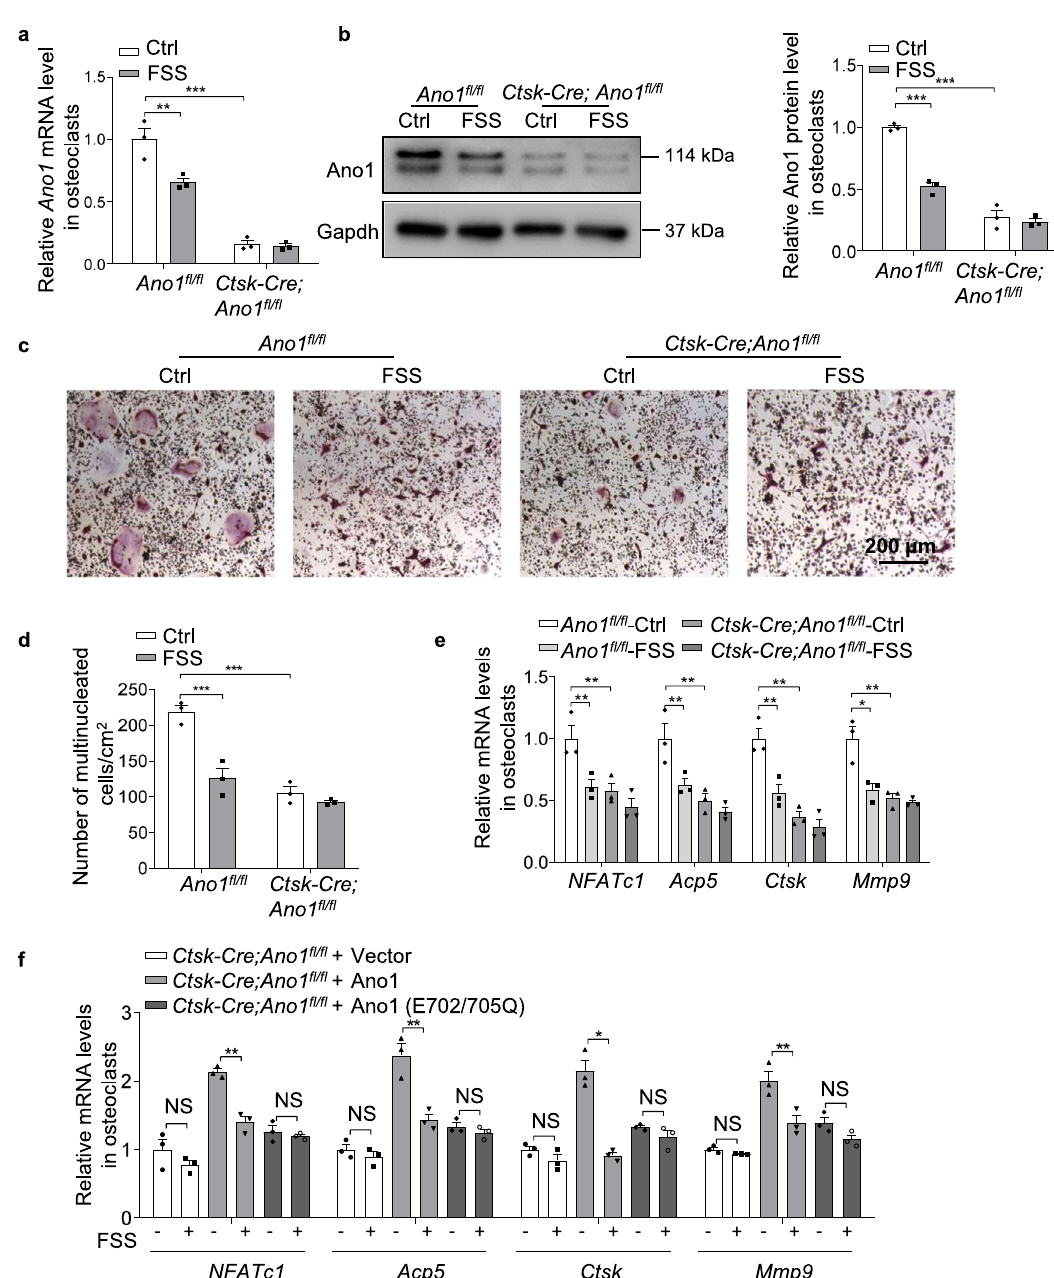
Fig. 2 Ano1 knock out blunts the inhibition of fl uid shear stress on osteoclast activity. a QRT-PCR analysis of Ano1 mRNA level in Ano1 fl / fl and Ctsk- Cre;Ano1 fl / fl osteoclasts after treatment with Ctrl or FSS (12 dyn/cm 2 , 30 min/day) for 2 days. ( n = 3 independent experiments). b Western blot analysis of Ano1 protein level in Ano1 fl / fl and Ctsk-Cre;Ano1 fl / fl osteoclasts after treatment with Ctrl or FSS (left). The quanti fi cation of Ano1 protein level in osteoclasts (right). ( n = 3 independent experiments). c Representative images of TRAP staining in Ano1 fl / fl and Ctsk-Cre;Ano1 fl / fl osteoclasts after treatment with Ctrl or FSS (12 dyn/cm 2 , 30 min/day) for 2 days. Scale bar, 200 μ m. d Quanti fi cation of the number of multinucleated cells per cm 2 . ( n = 89 – 231, from three independent experiments). e QRT-PCR analysis of NFATc1 , Acp5 , Ctsk and Mmp9 mRNA levels in osteoclasts Ano1 fl / fl and Ctsk-Cre;Ano1 fl / fl osteoclasts after treatment with Ctrl or FSS for 2 days. ( n = 3 independent experiments). f QRT-PCR analysis of NFATc1 , Acp5 , Ctsk and Mmp9 mRNA levels in osteoclasts isolated from Ctsk-Cre;Ano1 fl / fl mice. Osteoclasts were transfected with NC, WT Ano1 or mutant Ano1 (E702/705Q) and treated with or without FSS for 2 days. ( n = 3 independent experiments).All data are the mean ± s.e.m. Statistical analysis with more than two groups was performed with two-way analysis of variance (ANOVA) with Š ídák post-hoc test to determine group differences. *p < 0.05, **p < 0.01, ***p < observed in Ano1 fl / fl mice (Fig. 7e). Osteoclast surface per bone Ctsk-Cre;Ano1 fl / fl mice than that in the control mice (Fig. 7c, d). Next, we analyzed the corresponding changes in osteoclast surface (Oc.S/BS) and number of osteoclasts per bone perimeter function after HS treatment. TRAP staining showed obviously (N.Oc/B.Pm) in the proximal tibia of Ctsk-Cre;Ano1 fl / fl mice subjected to HS were much lower than that in the Ano1 fl / fl mice increased osteoclast activity in the Ano1 fl / fl mice subjected to HS. However, HS induced only a small increase in TRAP activity in (Fig. 7f). Accordingly, the level of CTX-1 showed signi fi cantly Ctsk-Cre;Ano1 fl / fl mice, which was much weaker than that increased in serum from the Ano1 fl / fl mice, while with a little